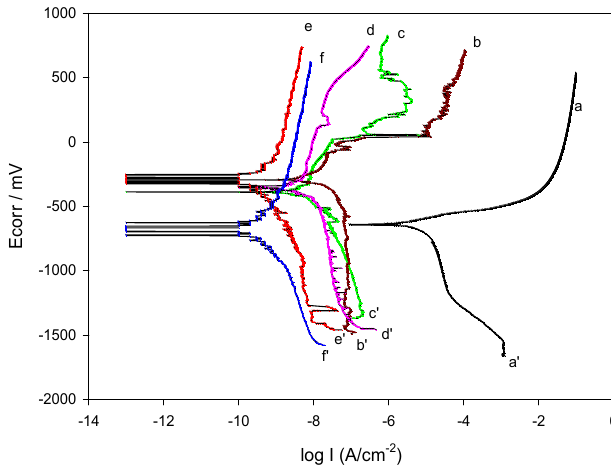
Figure 2. Typical polarization curves of film-GPMS-SSO (f-GS) (aa’) f-GSTT (cc’), f-GSTT (dd’), f-GSTT (ee’) and f-GSTT f-GSTT 10% 15% 20% measured in 3.5 wt% NaCl aqueous